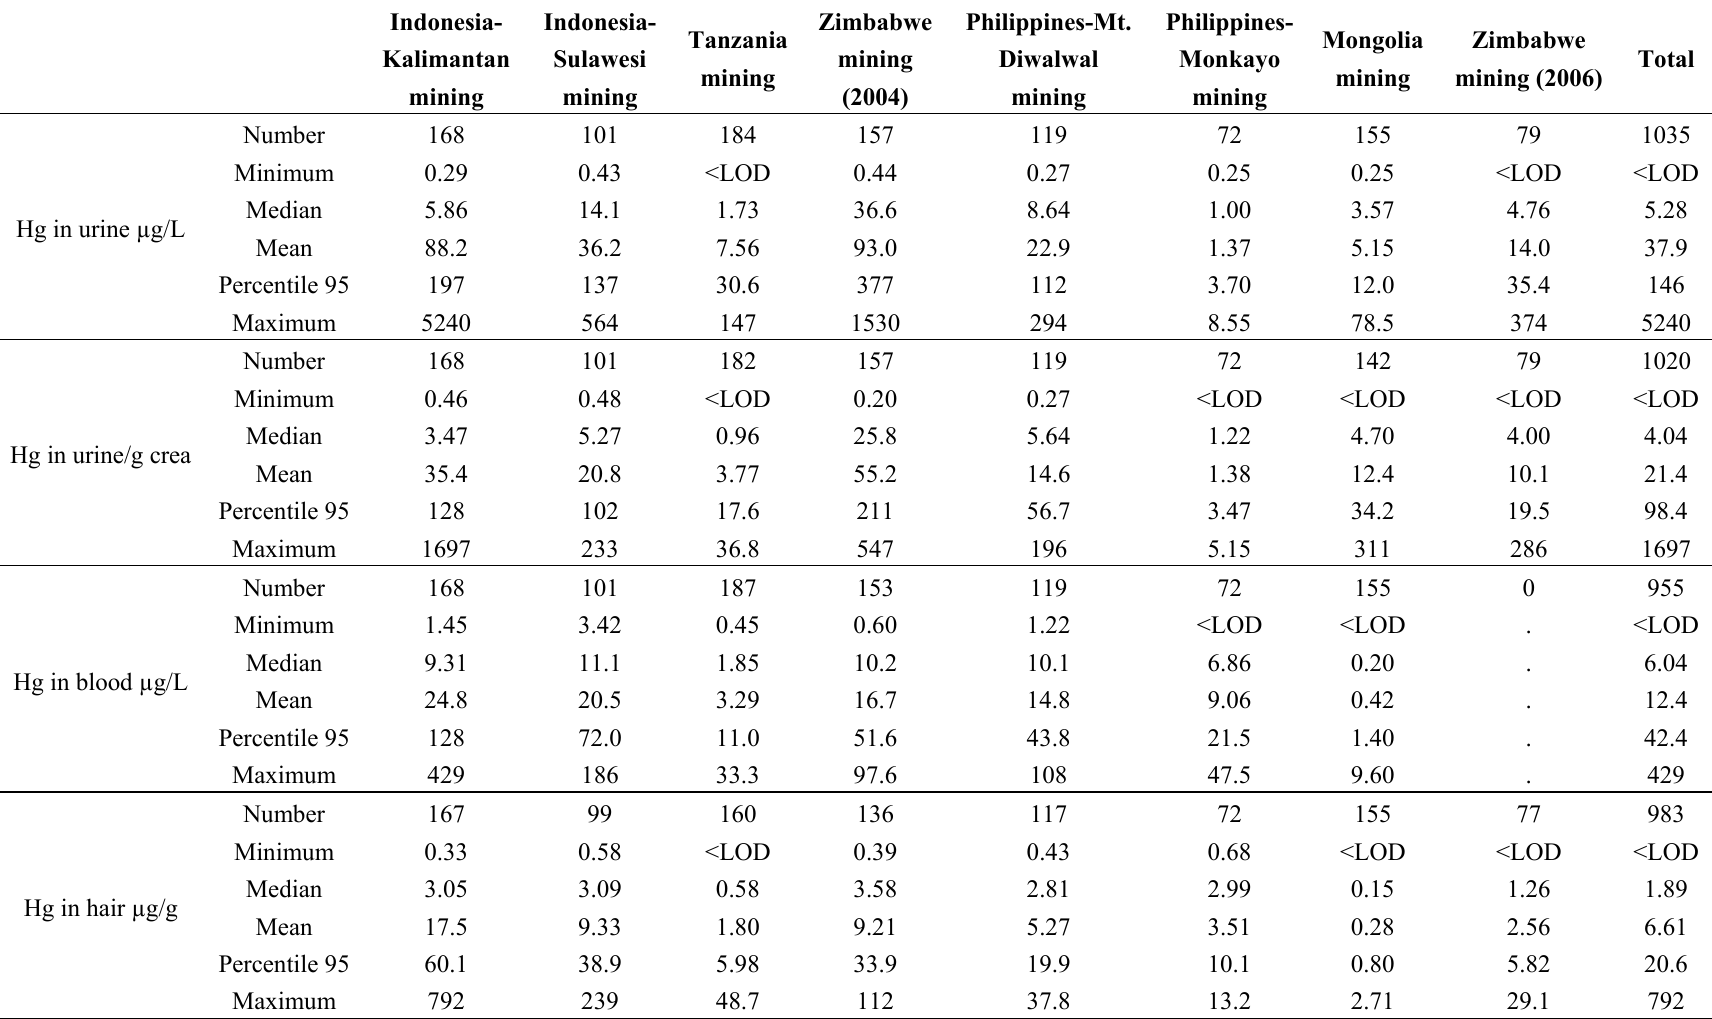
Table 2. Mercury in human specimens for each mining